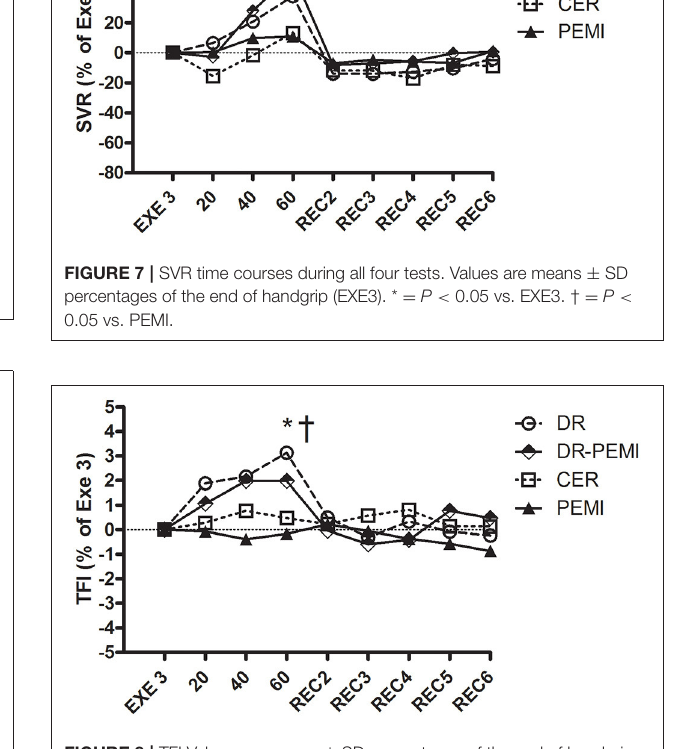
gradually returned to the Exe3 level.